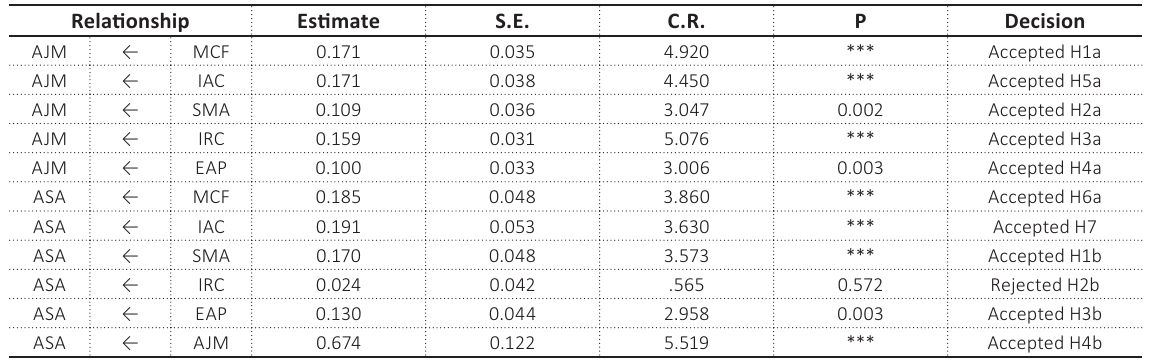
Table 5. Results on the hypothesis testing